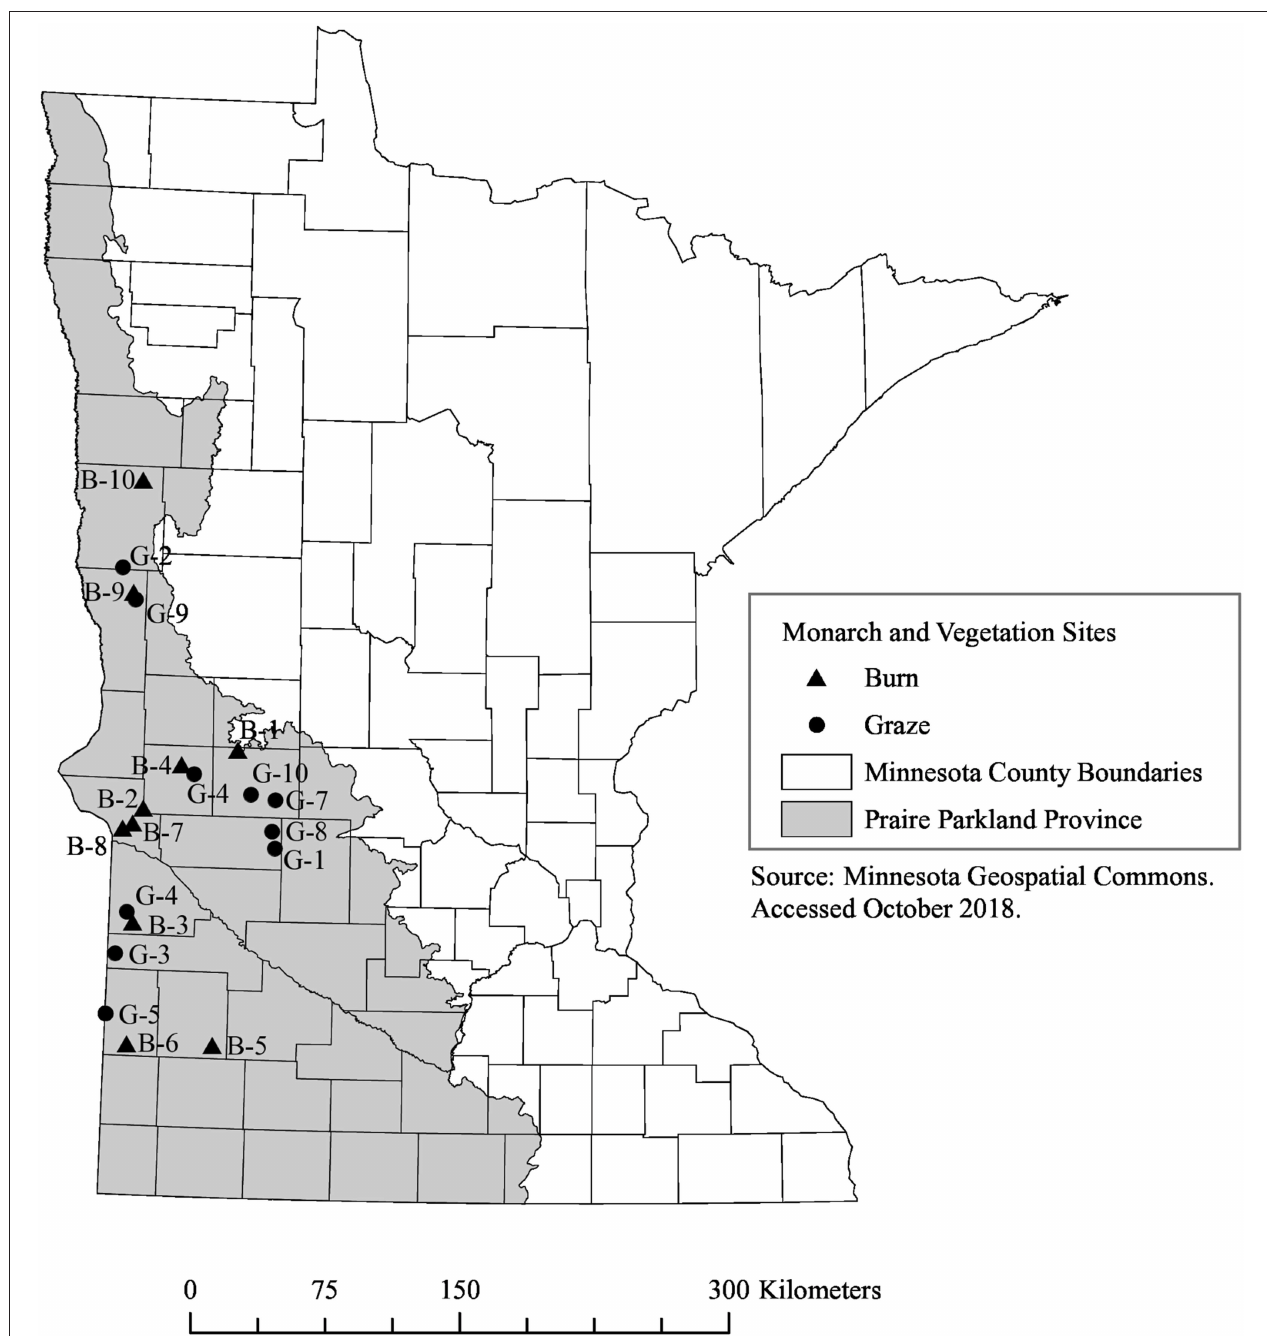
FIGURE 1 | Map of 10 burned (triangles, B 1–10) and 10 grazed (circles, G 1–10) remnant prairie sites where vegetation and monarchs were surveyed in Minnesota in 2016 and 2017. Bounding coordinates for map are West: − 97.02026367158, East: − 95.372314452892, North: 46.754616856587, South: 43.627806711488.